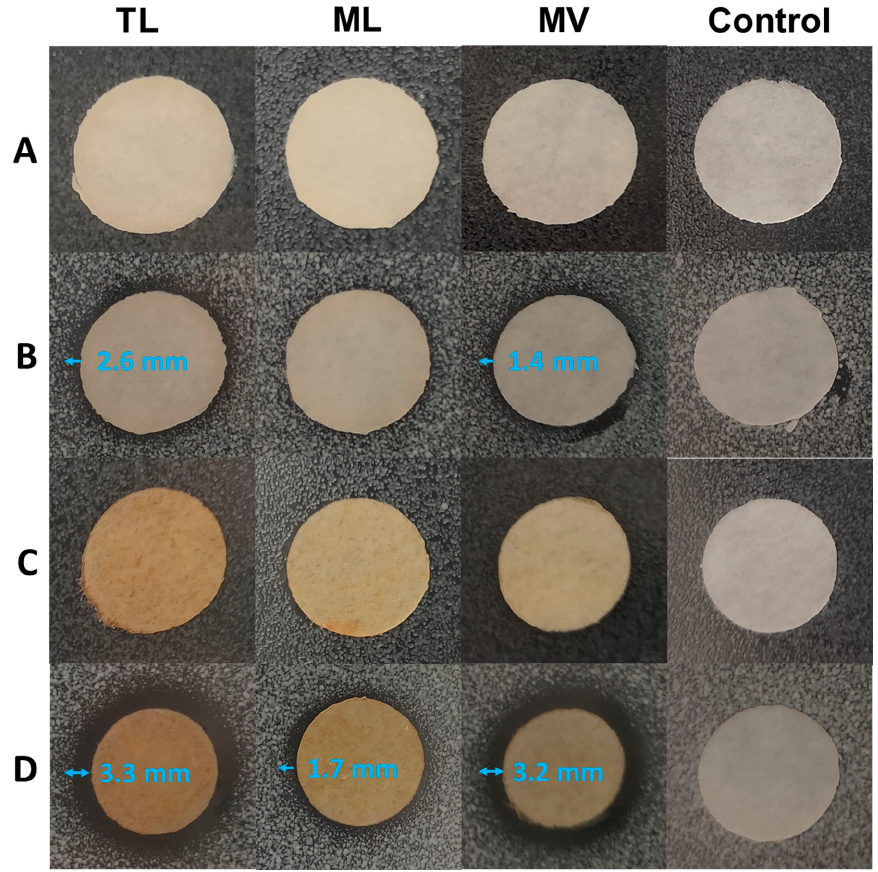
Figure 7. Zone of inhibition test for the plasticizers loaded on paper disks against E. coli and S. aureus ( A : 1 mg of plasticizers and E. coli ; B : 1 mg of plasticizers and S. aureus ; C : 5 mg of plasticizers and E. coli ; D : 5 mg of plasticizers and S. aureus ).